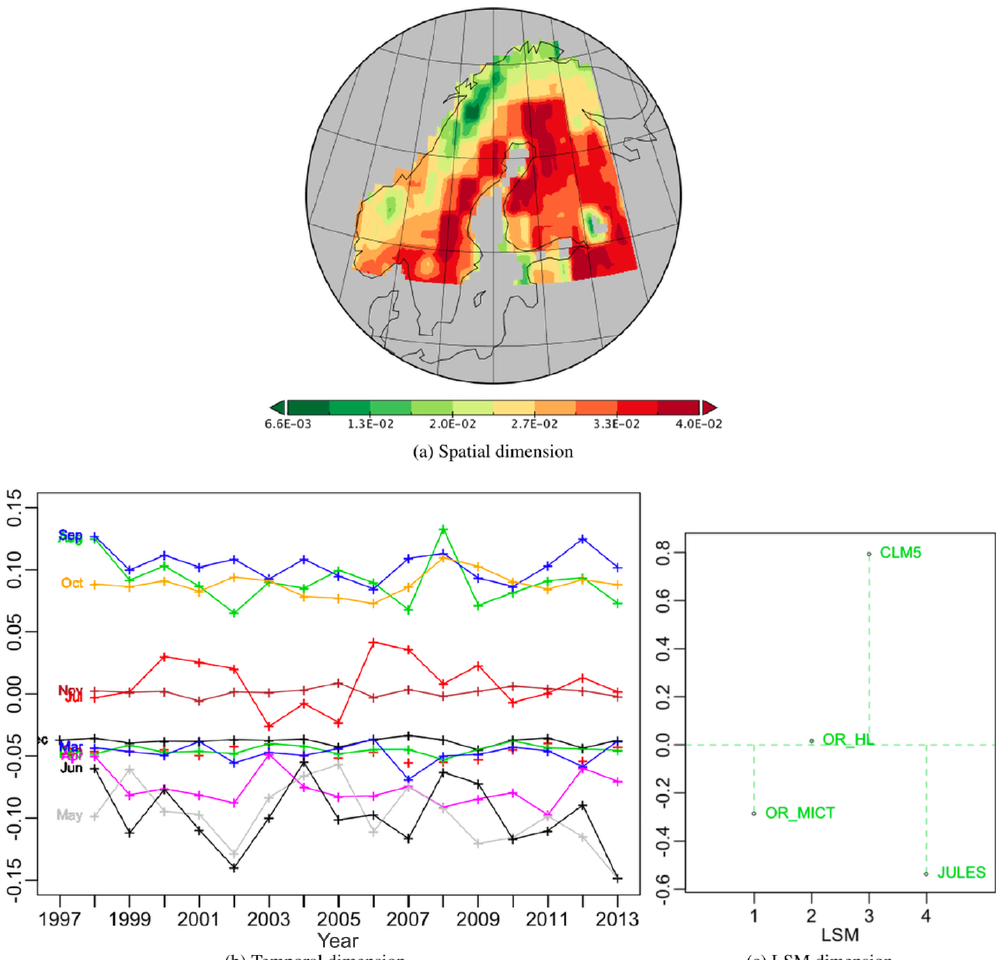
Figure 5. Plots for PT -no-3 associated with PT -no-1 along the spatial dimension, which is therefore identical to Fig. 3a; it represents 1.72% of the